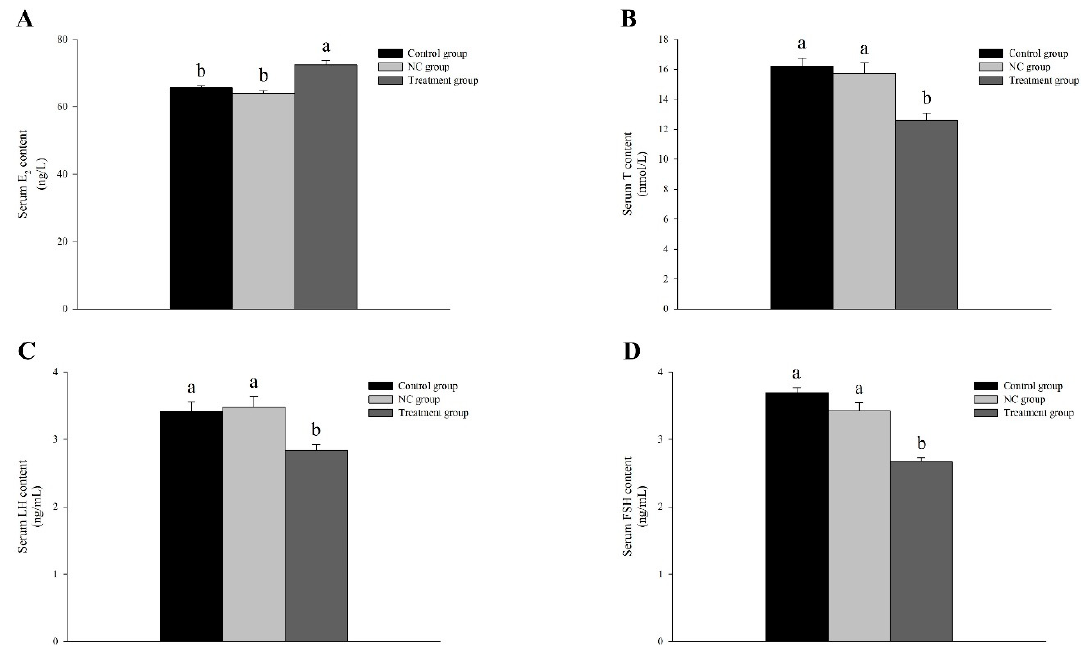
Figure 5. Serum hormone contents in Nile tilapia after transfection of vector-encoding antisense RNA ( n = 12 replicates). ( A ) serum E2 content, ( B ) serum T content, ( C ) serum LH content, ( D ) serum FSH content. Different lowercase letters indicate significant differences ( p < 0.05).